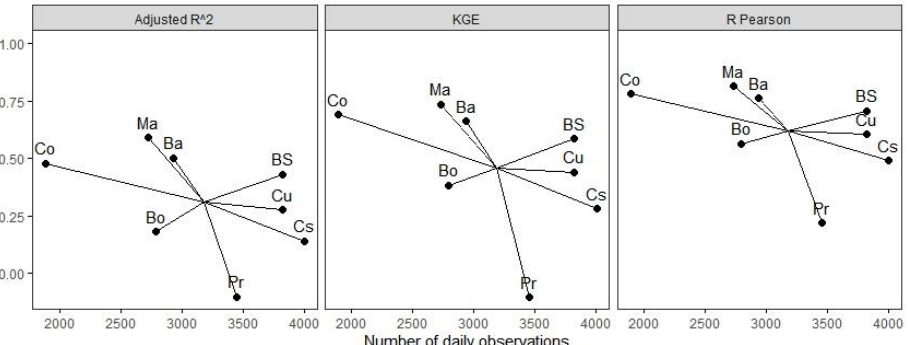
Figure 5. Plot between the number of daily observations ( x -axis) for Q 50 models (second-order) in the SON a set and their model skills ( y -axis).